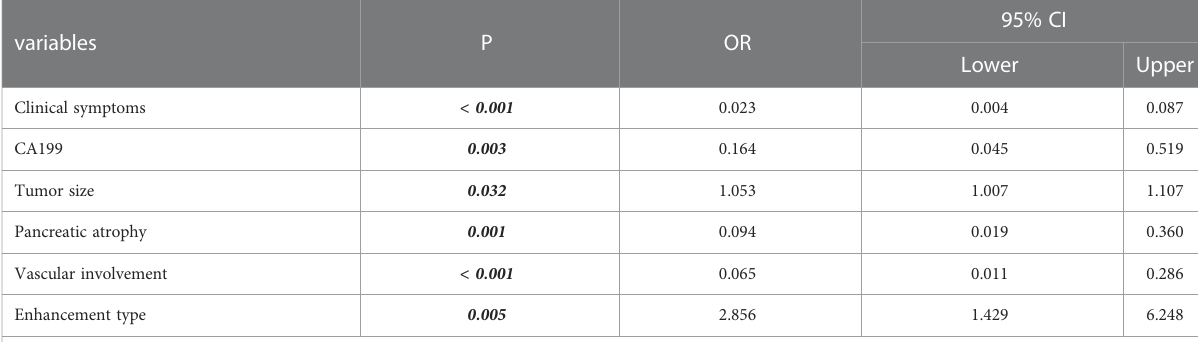
TABLE 5 Six optimal independent predictors for PM-SCLC diagnosis in multivariate logistic regression analysis.